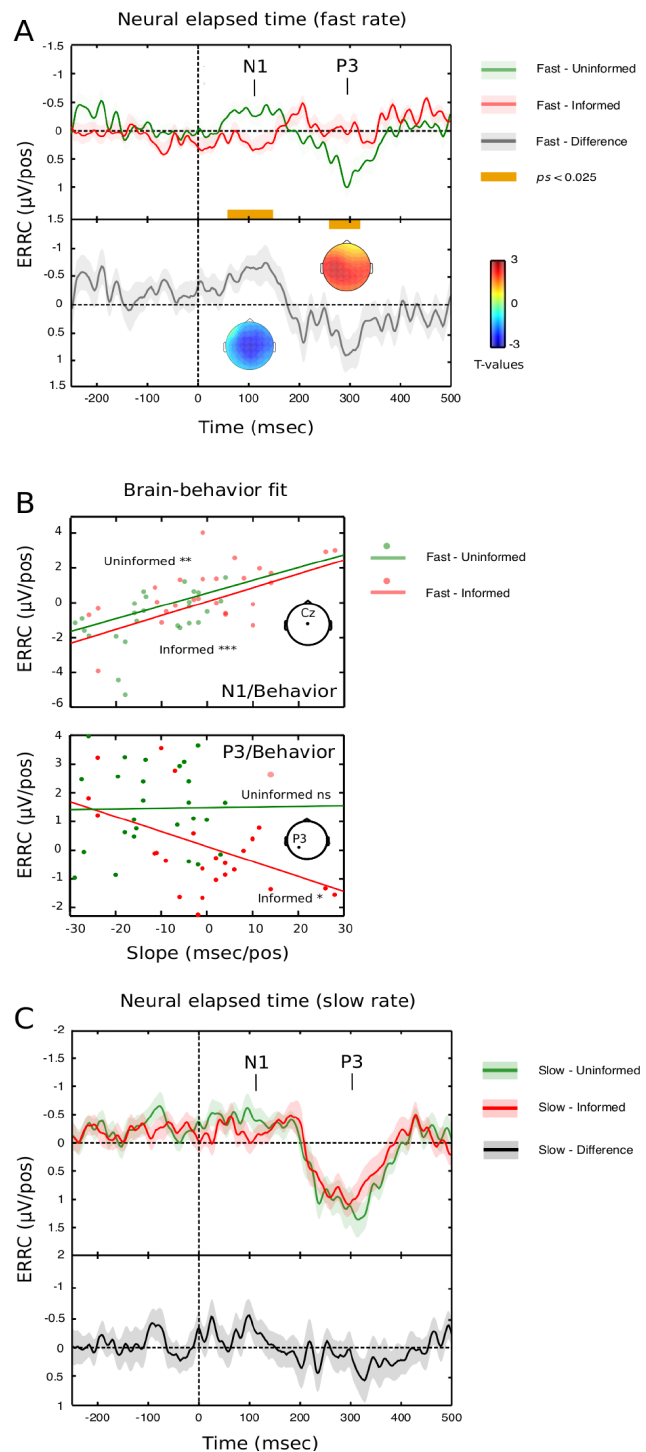
Fig 3. The hazard rate of sensory processing. In the uninformed, fast condition, significant deflections in ERRC activity were found at N1 and P3 latencies. There was no significant activity in the informed condition for the first ~400 ms after target onset. ERRC cluster statistic values averaged across the electrode space show a significant effect of prior information at N1 and P3 latencies, with a central distribution for the negative cluster and a left-sided centroparietal distribution for the positive cluster, consistent with the N1 and P3 interpretations. B. ERRCs at